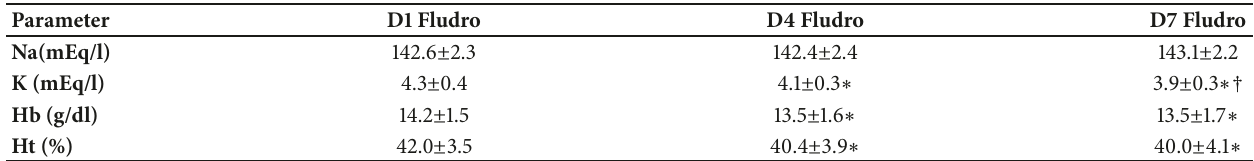
Table 2: La b oratory data during the fl udrocortisone phase . Na = sodium; K = potassium; Hb = hemoglobin; Ht = hematocrit; D1 Fludro, D4 Fludro, D7 Fludro = 1st, 4th, and 7th days of fludrocortisone, respectively. Data as mean ± standard deviation, compared by repeated measure analysis of variance followed by modified Tukey’s. ∗ p < 0.05 vs. D1 Fludro, † p < 0.05 vs. D4 Fludro.